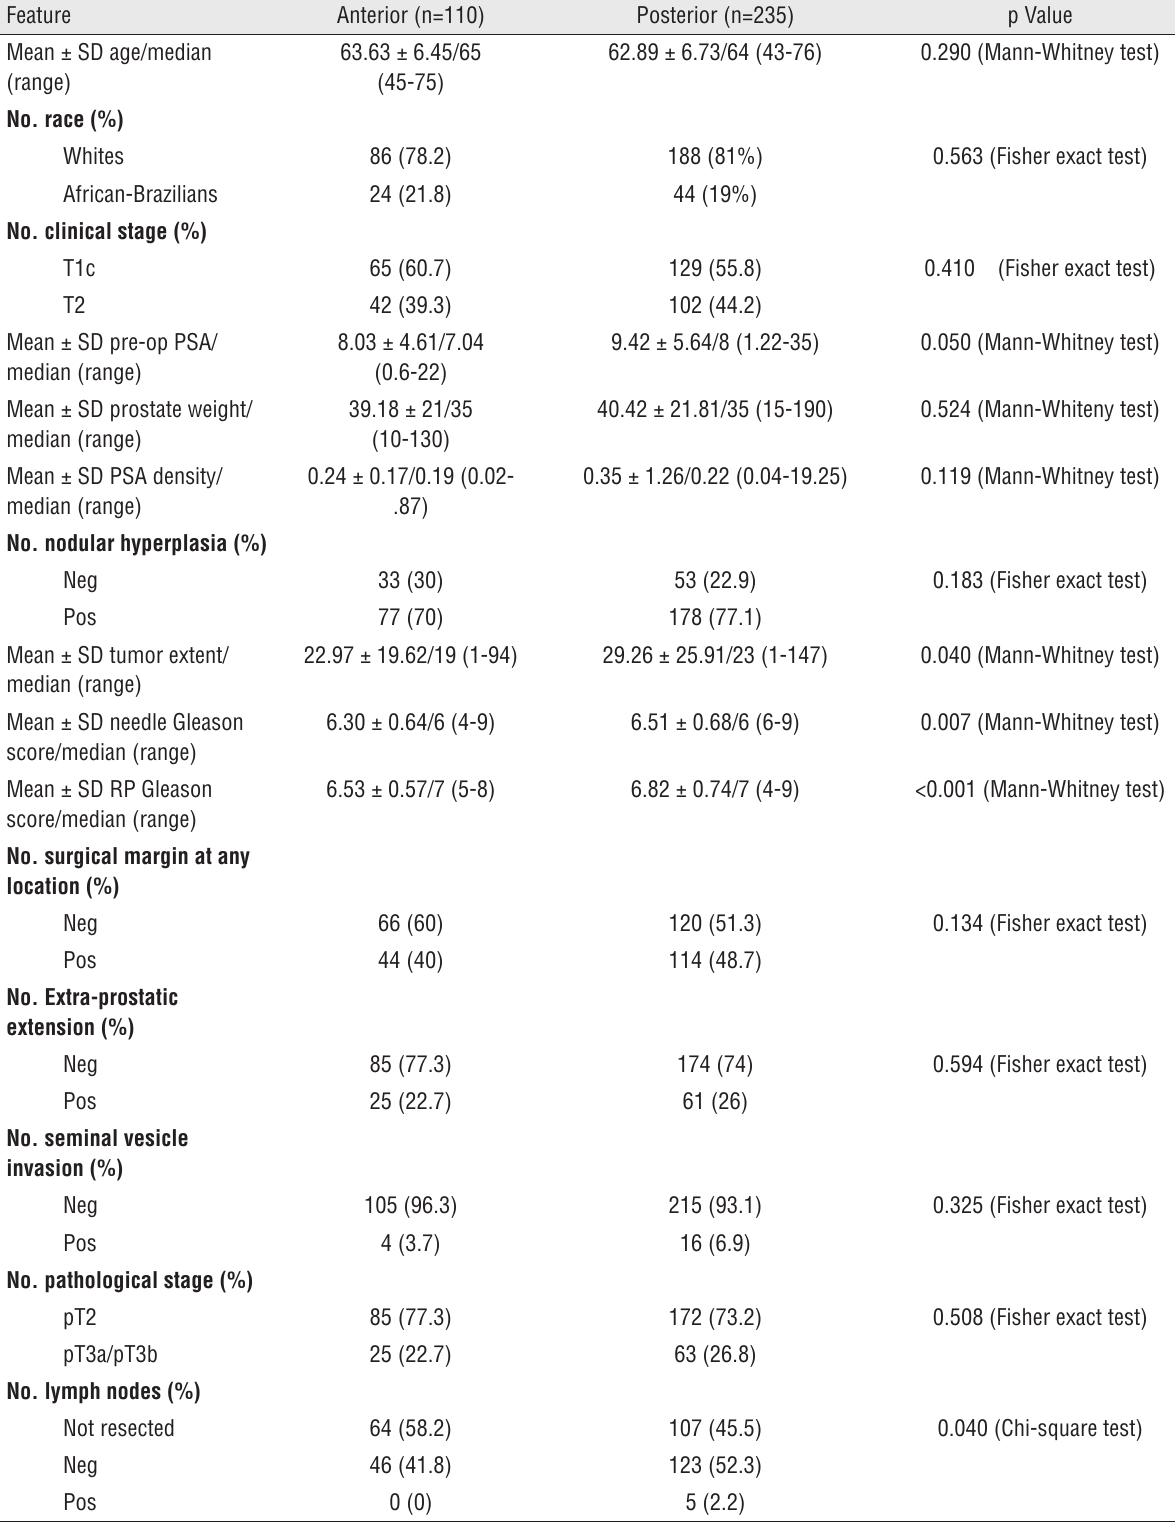
Table 1 - clinicopathological features of 345 patients by index tumor predominant